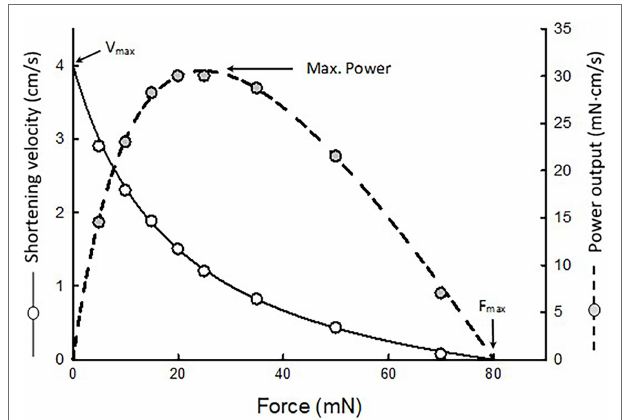
FIGURE 2 | An example of force–velocity data fitted by the Hill equation. The maximal shortening velocity (V max ) and maximal isometric force (F max ) are extrapolated from the fitted curve. Because the muscle’s power output is the product of force and velocity, a force–power curve (dotted curve) can be derived from the force–velocity